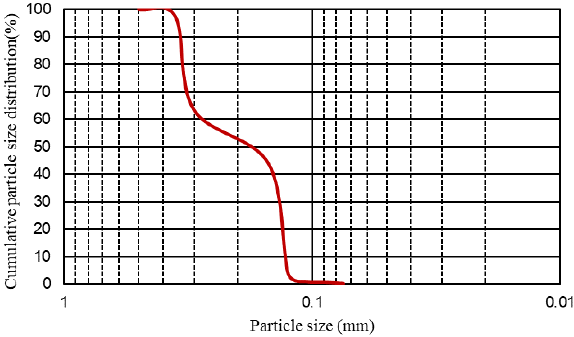
Figure 3. Particle size distribution of the test soil.